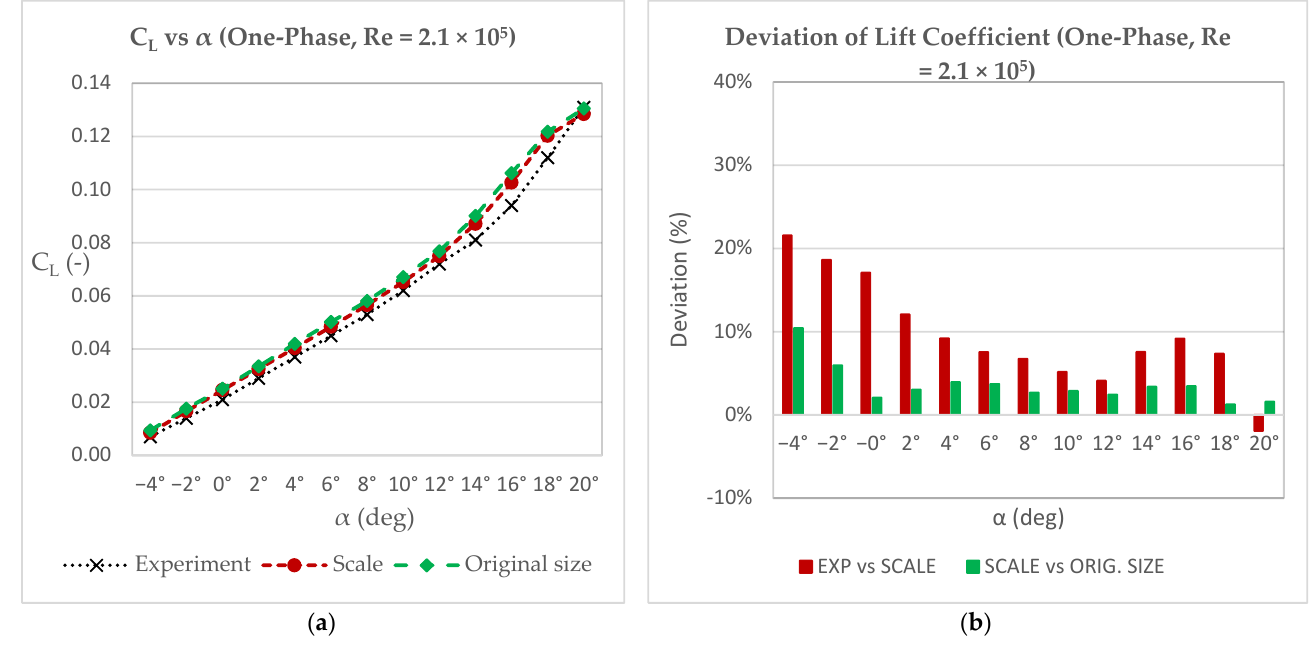
Figure 7. One-phase flow: ( a ) lift coefficient of wing, from numerical simulations of original model and downscaled model, as well as from wind-tunnel experiment; ( b ) deviation of lift coefficient between experiment and downscaled model simulation and between original and downscaled model simulation.